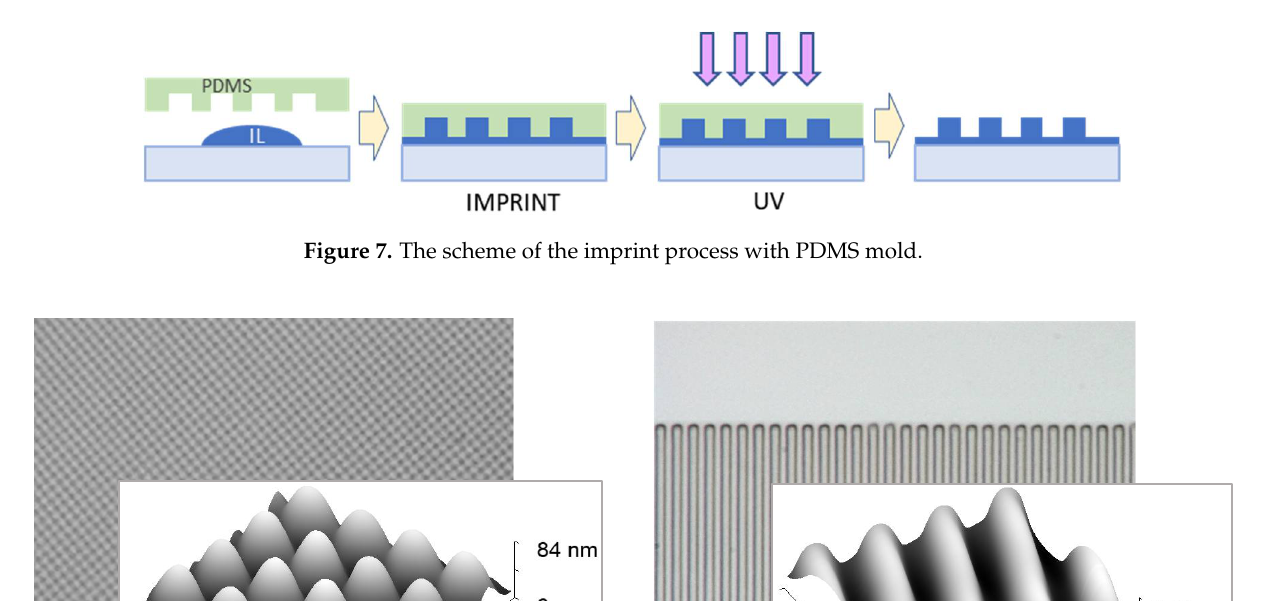
Figure 7. The scheme of the imprint process with PDMS mold .